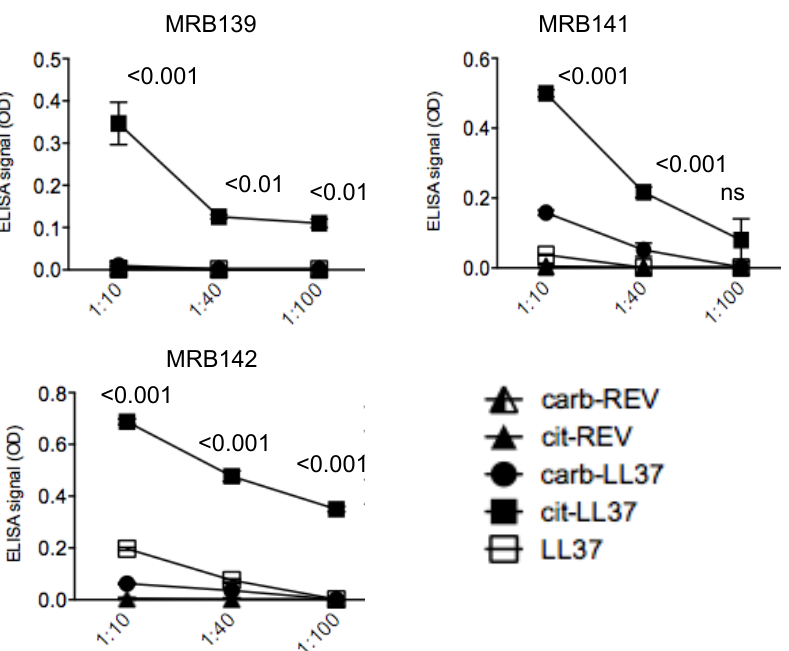
Figure 4. MRB139, MRB141 and MRB142 do not recognize carb-LL37 and are not merely citrulline or homocitrulline specific. MRB139, MRB141 and MRB142 were diluted in ELISA plates coated with native LL37 or cit-LL37 or carb-LL37 and control REV LL37 peptides (REV) either in their citrullinated or carbamylated form (cit-REV, carb-REV), at the indicated dilutions. ELISA tests were performed as in Material and Methods. Results are expressed as the mean of triplicate cultures. Standard errors of the mean are indicated. Representative results form three independent experiments. p values by Student’s paired t -test (two-tailed) refer to di ff erence between recognition of cit-LL37 as compared to all the other control peptides as indicated.